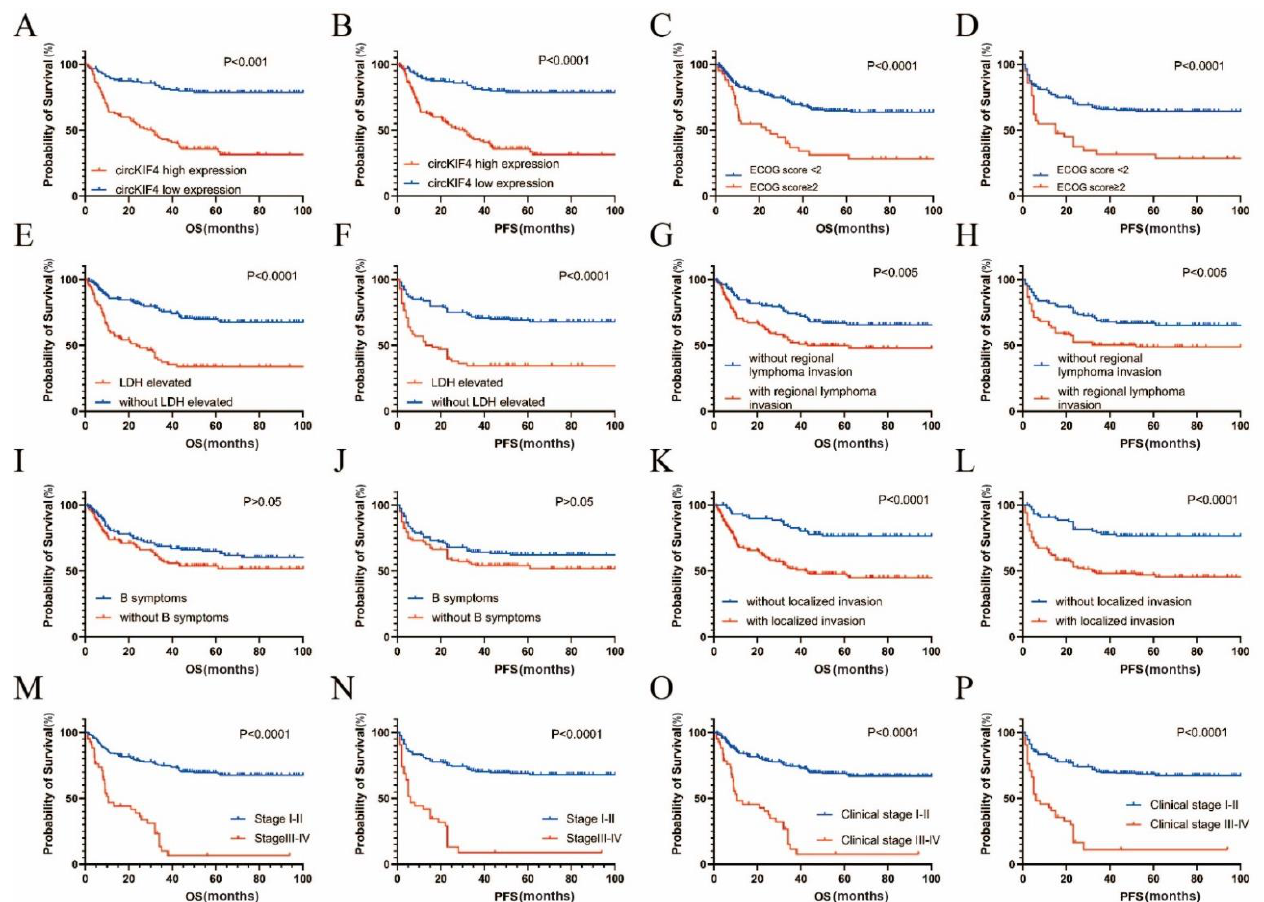
Figure 2. Correlation between clinicopathological features and circKIF4A expression and related survival rates in the 295 NKTL patients. ( A , B ) High circKIF4A expression levels correlated with poor OS and PFS. ( C , D ) ECOG scores of ≥ 2 correlated with poor OS and PFS. ( E , F ) Elevated LDH levels correlated with poor OS and PFS. ( G , H ) Regional lymph node invasion correlated with poor OS and PFS. ( I , J ) Presence or absence of B symptoms did not correlate with OS and PFS. ( K , L ) Localized invasion correlated with poor OS and PFS. ( M , N ) Patients with late stage exhibited poor OS and PFS. ( O , P ) Patients with a late clinical stage had poor OS and PFS.